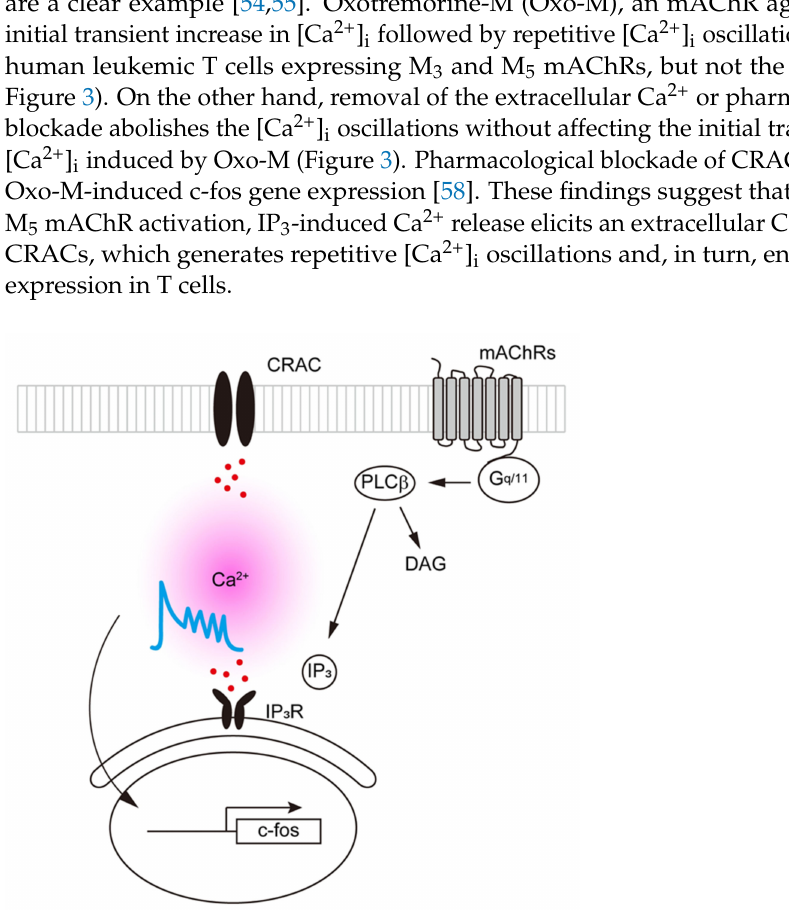
Figure 3. G q/11 -coupled mAChRs evoke [Ca 2+ ] i increases in T cells. G q/11 -coupled M 3 and/or M 5 mAChR activation results in IP 3 -mediated Ca 2+ release from the endoplasmic reticulum followed by extracellular Ca 2+ influx through CRACs, which mediate repetitive [Ca 2+ ] i oscillations in T cells. The increase in [Ca 2+ ] i is required to enhance c-fos gene